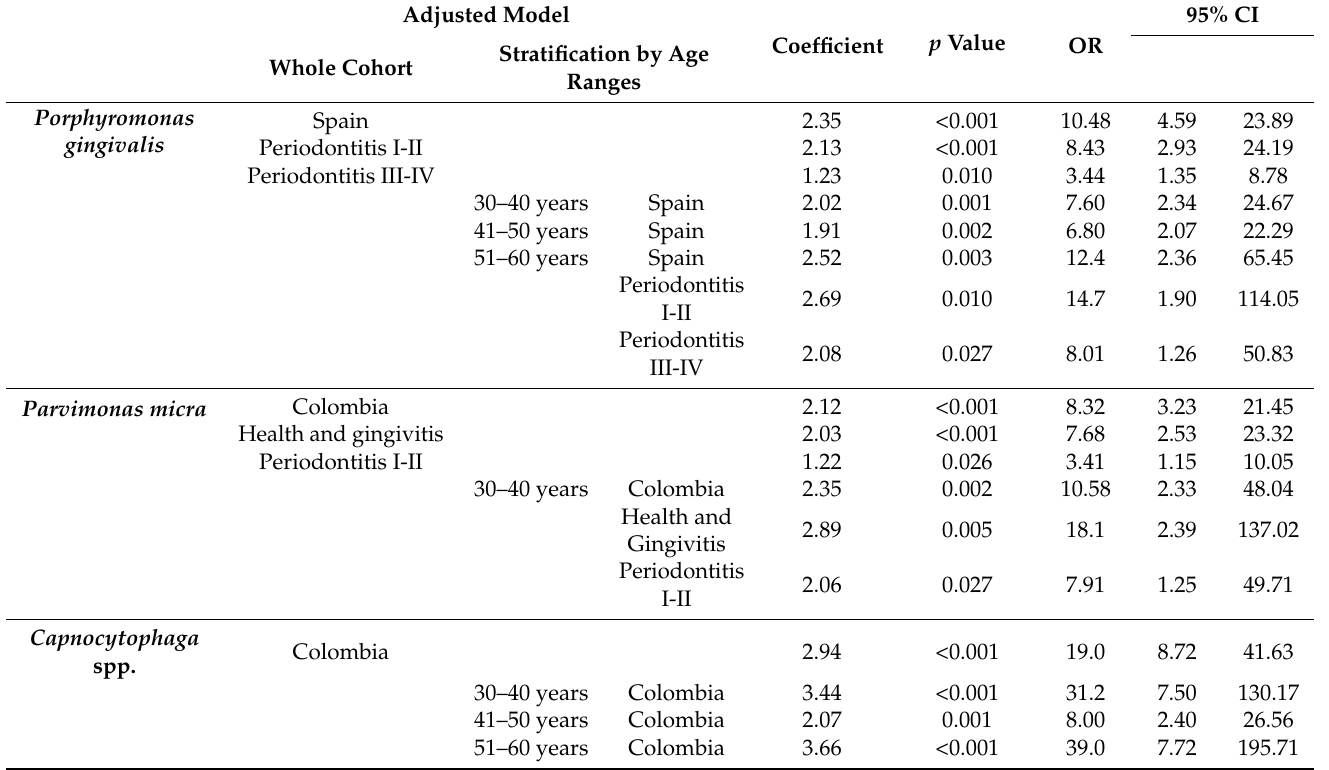
Table 6. Forward stepwise logistic regression analyses evaluating the detection of selected bacterial species considering country, smoking, periodontal status, and age as covariables in a first comparison with the whole cohort, and in a second comparison stratified by age